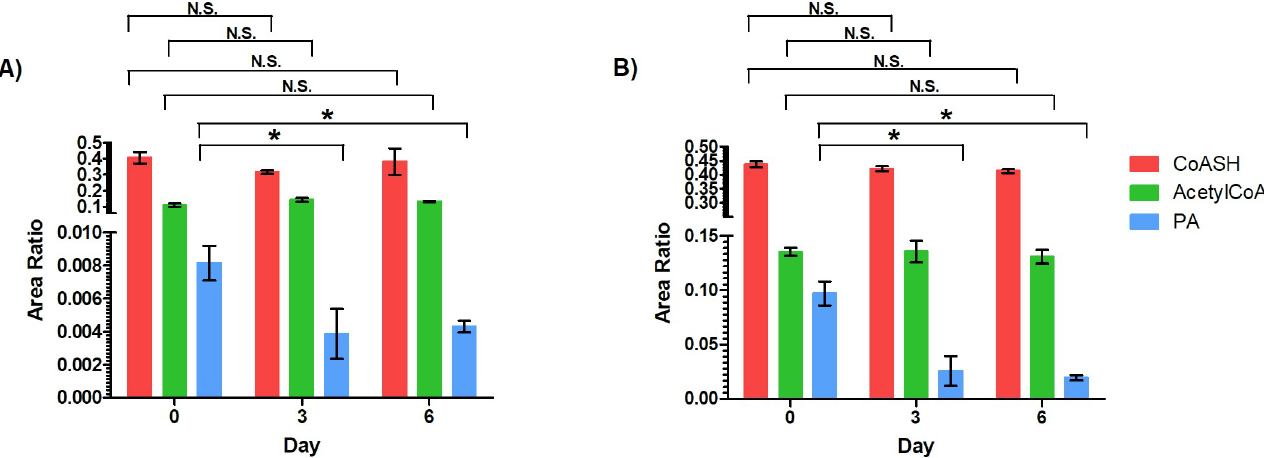
Fig 1. Levels of free CoA (CoASH), acetylCoA and pantothenic acid (PA) in male mouse A) liver and B) brain after administration of a low PA diet for 3 and 6 days. � p < 0.02; N.S. No Significance. Error bar, mean ± SD for triplicate samples.